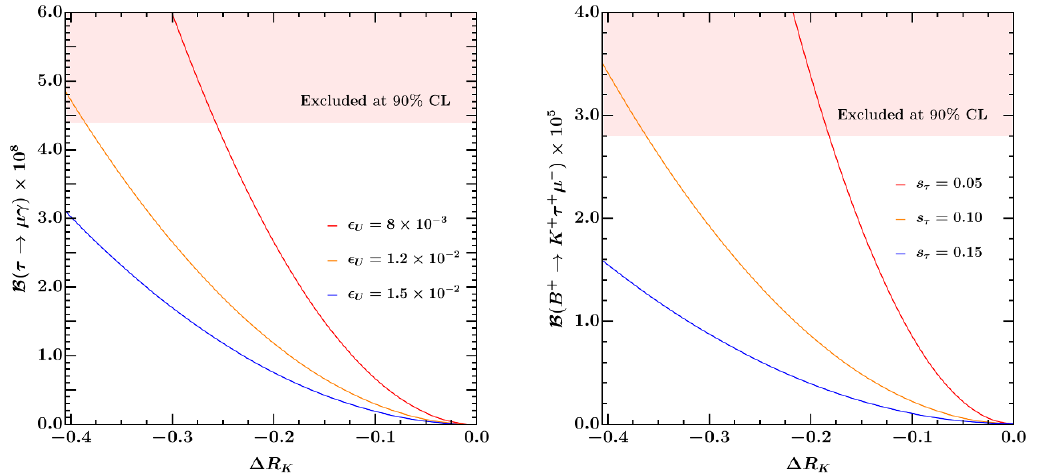
Figure 4 . Left: B ( (cid:28) ! (cid:22)(cid:13) ) as function of the NP shift in R K for di(cid:11)erent values of (cid:15) U . Right: B ( B + ! K + (cid:28) + (cid:22) (cid:0) ) as function of the NP shift in R K for di(cid:11)erent values of s (cid:28)